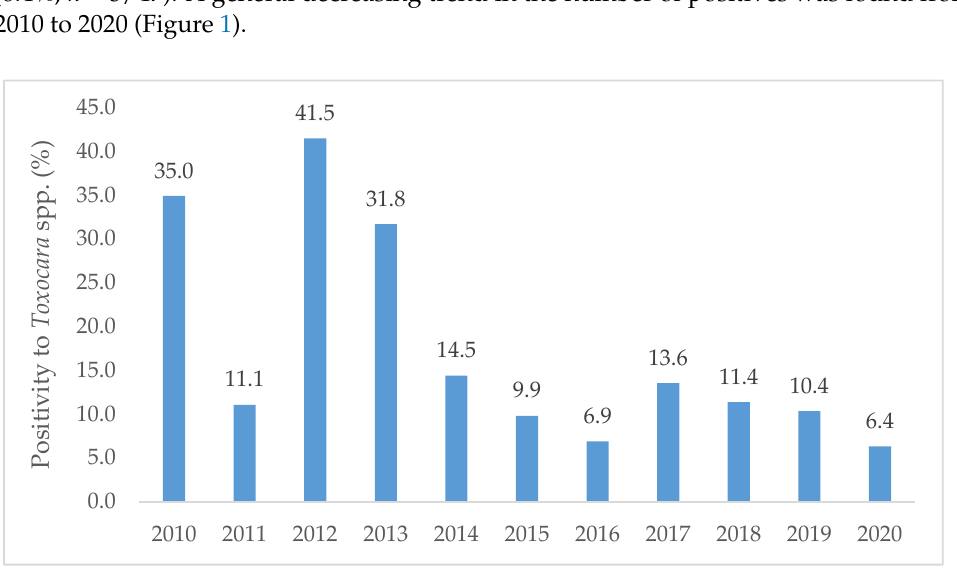
Figure 1. Percentage of positive samples to Toxocara spp. per year along the decade from 2010 to 2020, diagnosed at the Institute of Hygiene and Tropical Medicine.